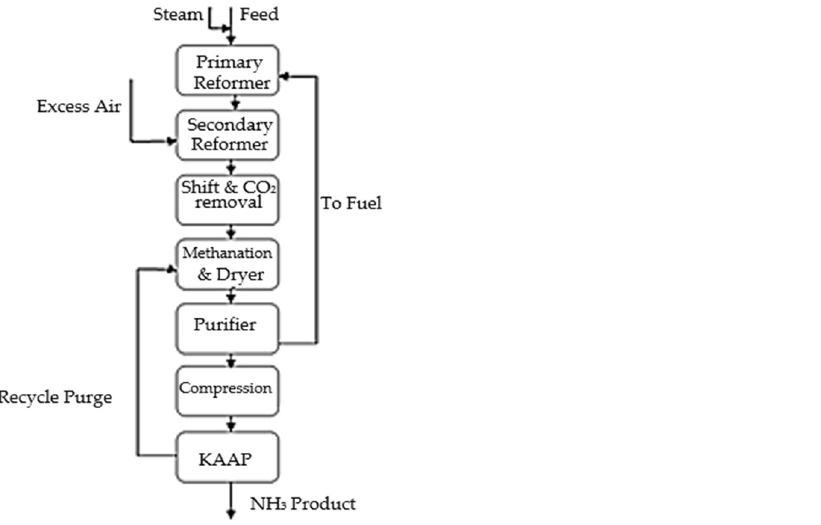
Figure 8. Purifier and KAAP concept, reproduced from References [35,36].